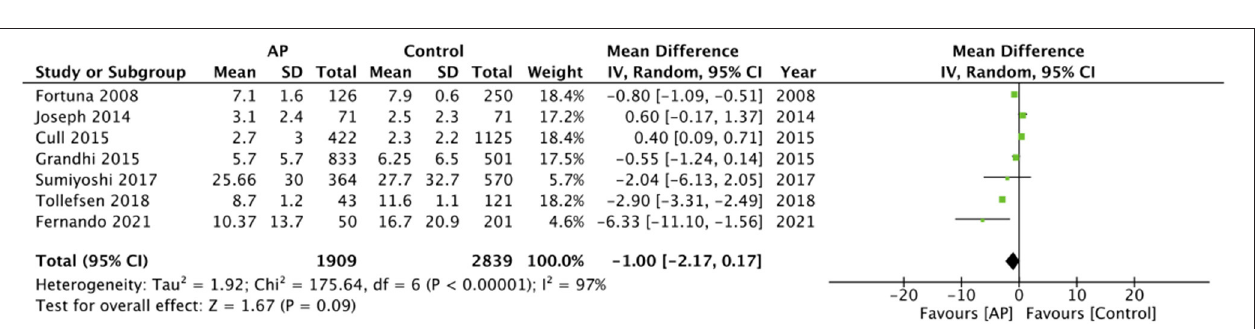
FIGURE 6 | Meta-analysis of length of hospital stay between antiplatelet users vs.